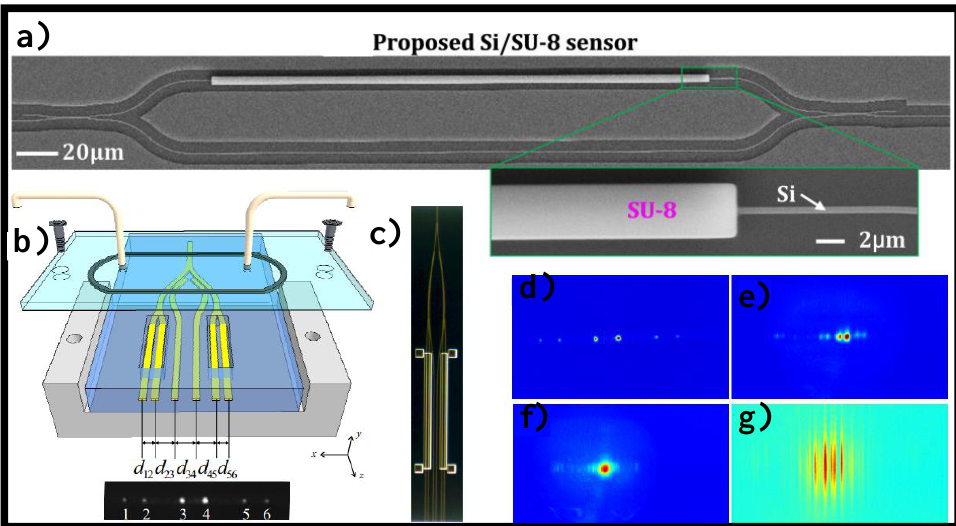
Figure 6. Recently proposed MZI and YI devices, ( a ) the suggested temperature sensing device established on MZI structure with Si–SU-8 hybrid WGs as seen in SEM [94], ( b ) a diagram of a corporate-feed YI, and its collimated outputs [95], ( c ) microscope picture of our multichannel corporate-feed structure [95], ( d ) the corporate-feed YI’s far-field mode outputs [95], ( e ) when a convex lens is installed and the camera is set in front of the focus point of the convex lens, the output beams reach each other [95], ( f ) when a convex lens is installed and the camera is placed at the focal point of the convex lens, the output beams overlap [95], ( g ) the interference pattern is formed when the camera is placed after the convex lens’ focus point [95]. Table 2. Previously proposed MZI and YI structures and their sensing performance. Sensor